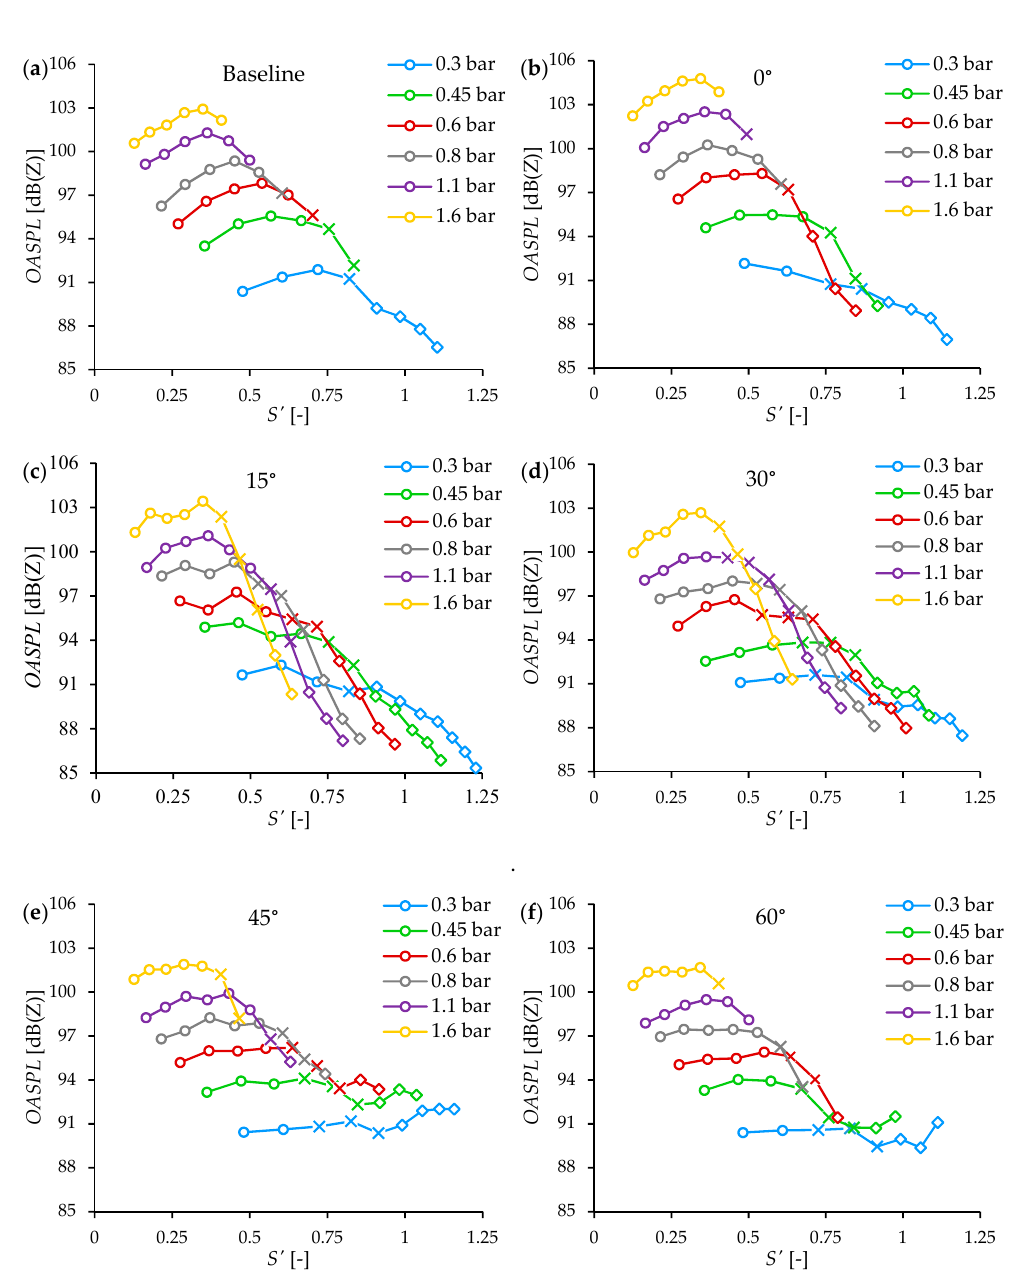
Figure 7. OASPL of the ( a ) baseline burner and ( b )–( f ) 0°–60° quarls at six p g s as a function of S’ , using Z-weighting. Symbols: straight flame ( ○ ), transitory state (×), and V-shaped flame ( ◊ ).